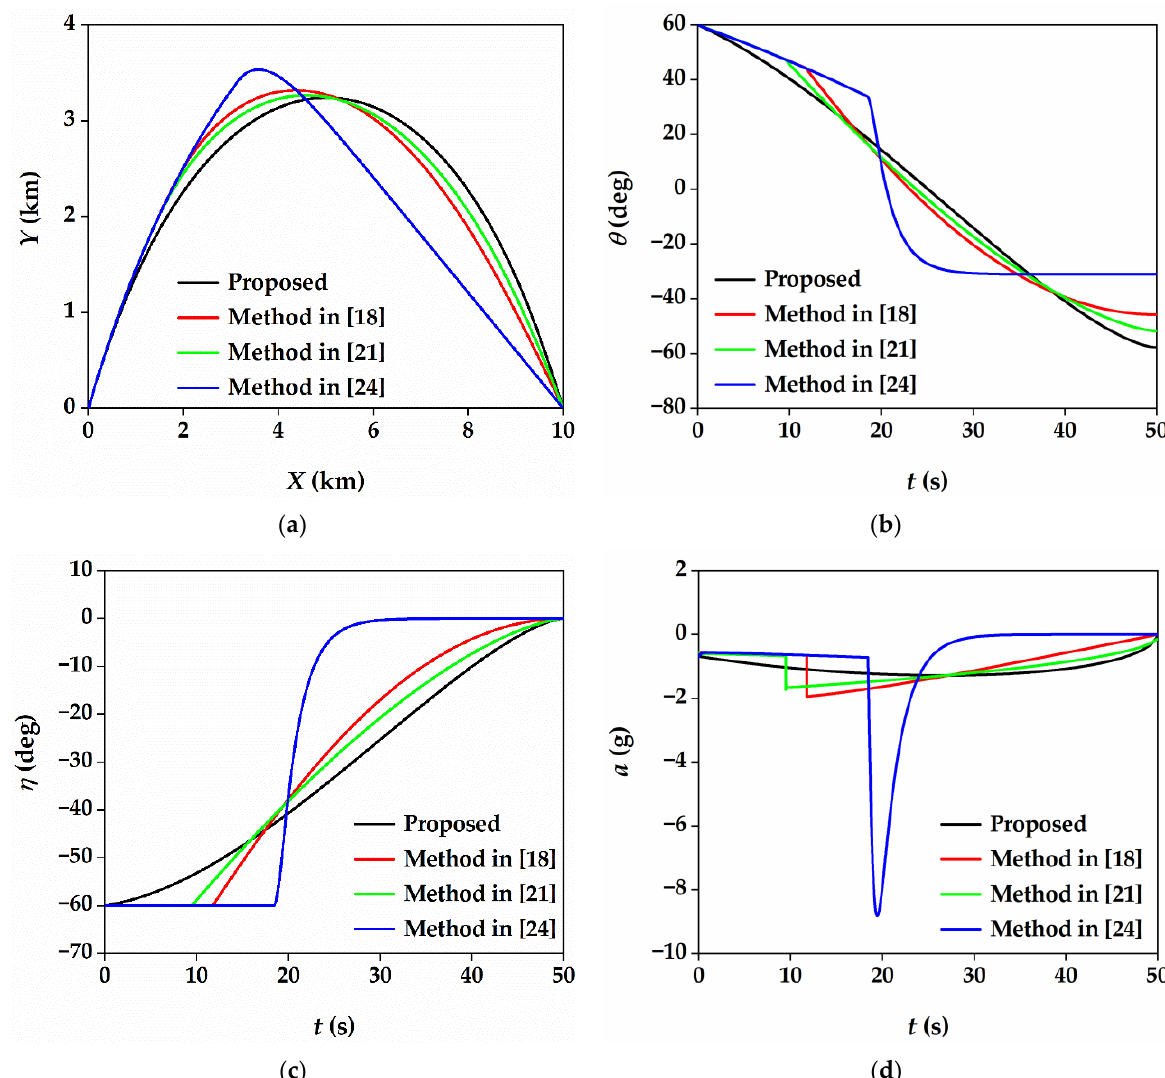
Figure 6. Simulation results of θ 0 = 60° under different guidance laws. ( a ) Missile flight trajectory; ( b ) Flight path angle; ( c ) Lead angle; ( d ) Missile acceleration.